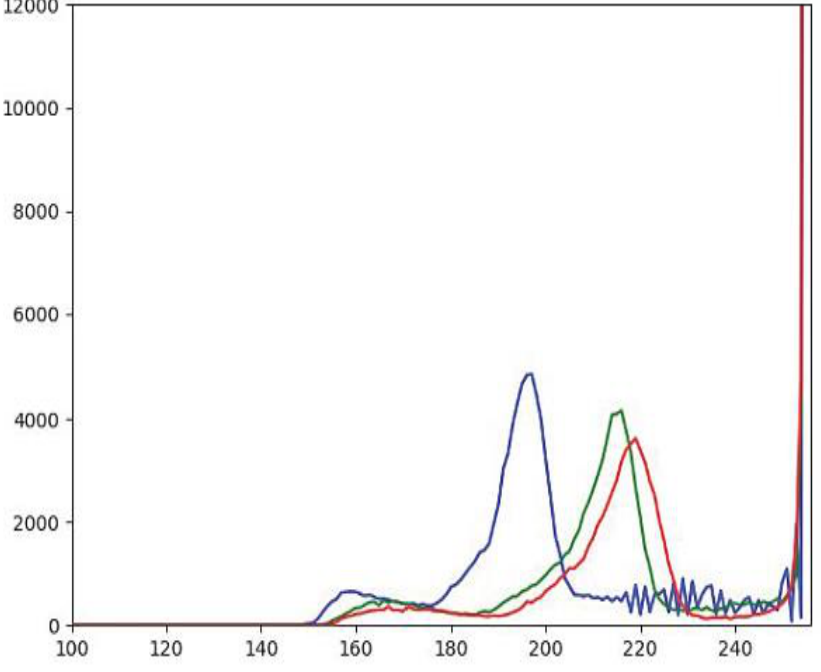
Figure 18. Histogram of the RGB graph for the image (see Figure